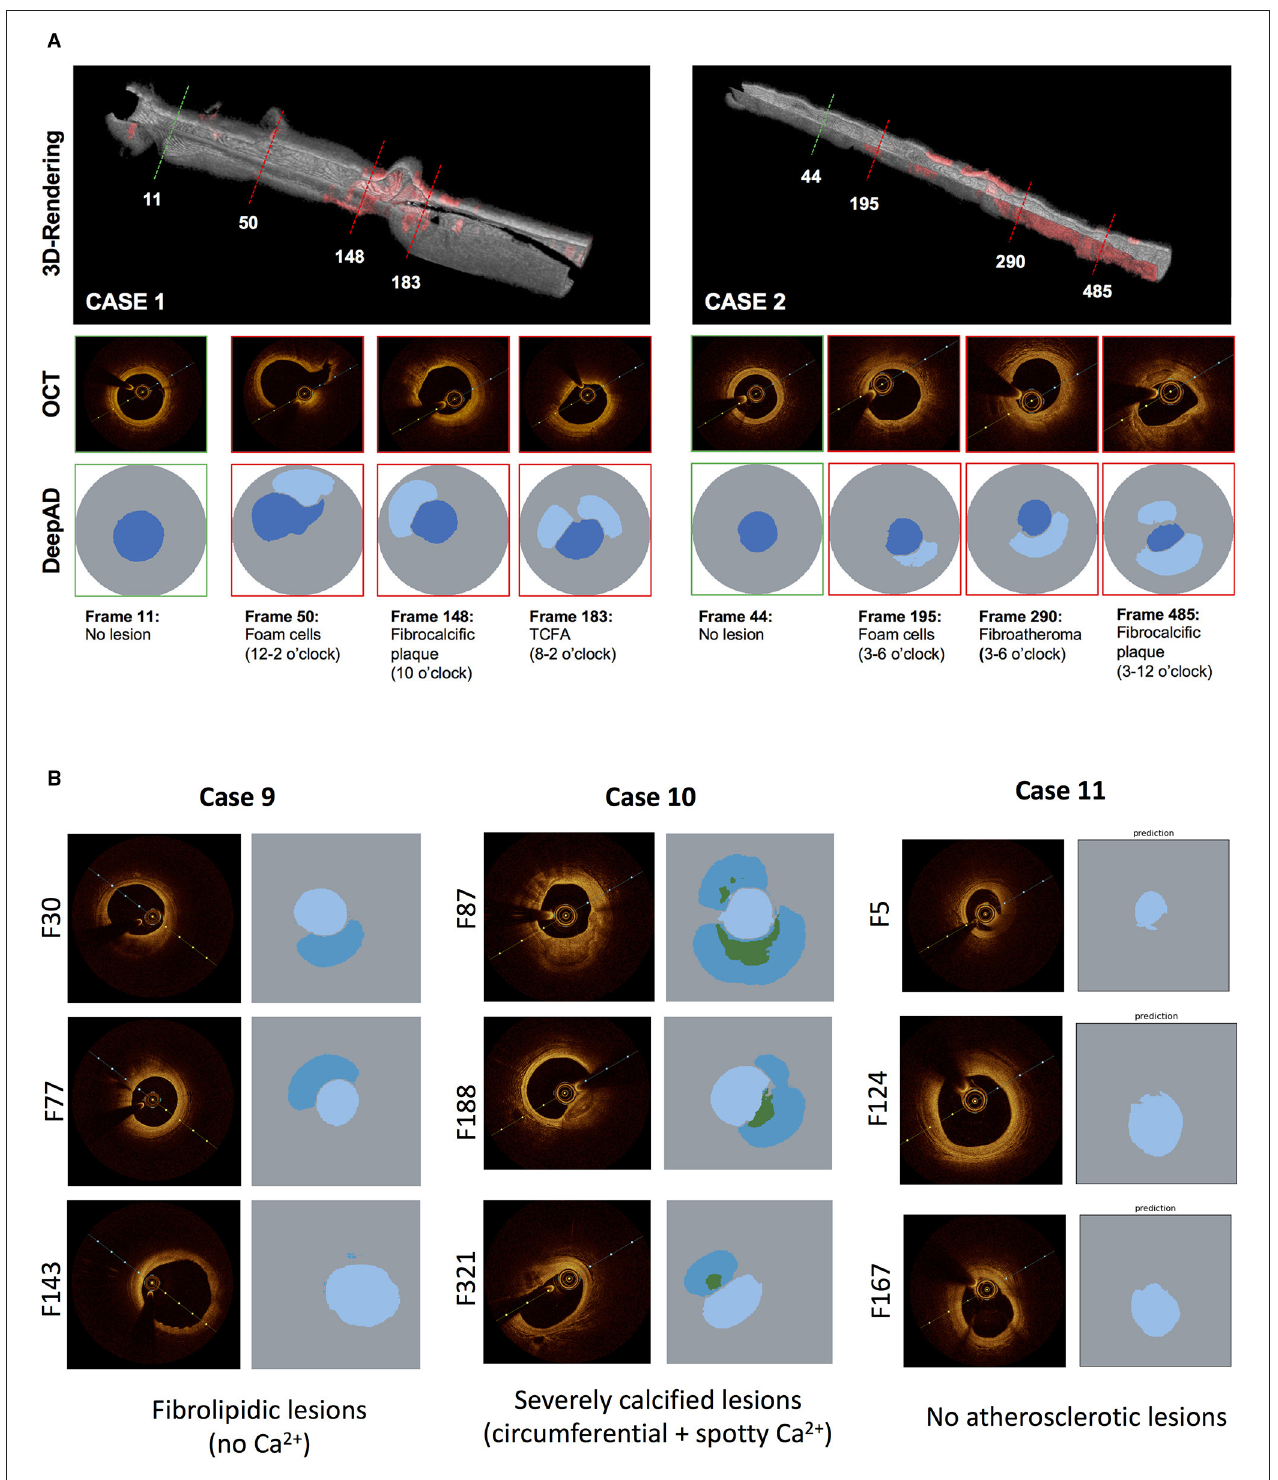
FIGURE 6 | (A) Application of DeepAD for lesion detection in clinical cases. 3D reconstruction of OCT pullback visualizes algorithm-based lesions detection (red). Representative cross-sections of healthy (green) and diseased (red lines) areas are shown with respective lesion detection by the DeepAD. (B) Subdifferentiation of calcified lesions by DeepAD. Representative OCT frames and corresponding predictions by DeepAD of 3 clinical cases from the clinical cohort (see Table 4 ). Case 9 mostly has fibrolipidic lesions without any calcifications while case 10 shows heavily calcified lesions (note that DeepAD is able to detect and differentiate circumferential and spotty calcifications). Case 11 shows almost no atherosclerotic lesions.